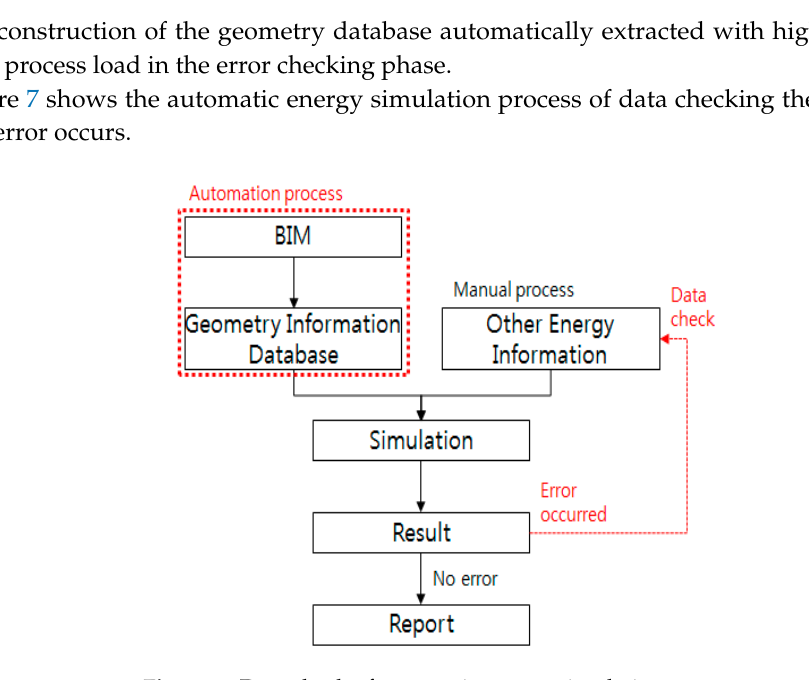
Figure 7. Data check of automatic energy simulation process.